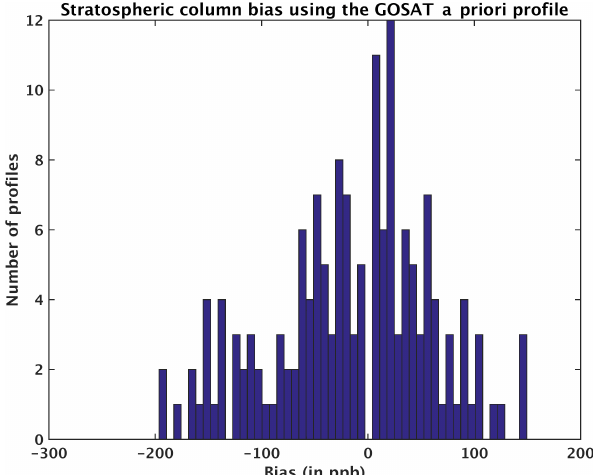
Figure 12. Stratospheric column error estimated at the MOZAIC airport locations when the GOSAT CH 4 a priori profile is used for aircraft profile extension. MIPAS data are taken as reference